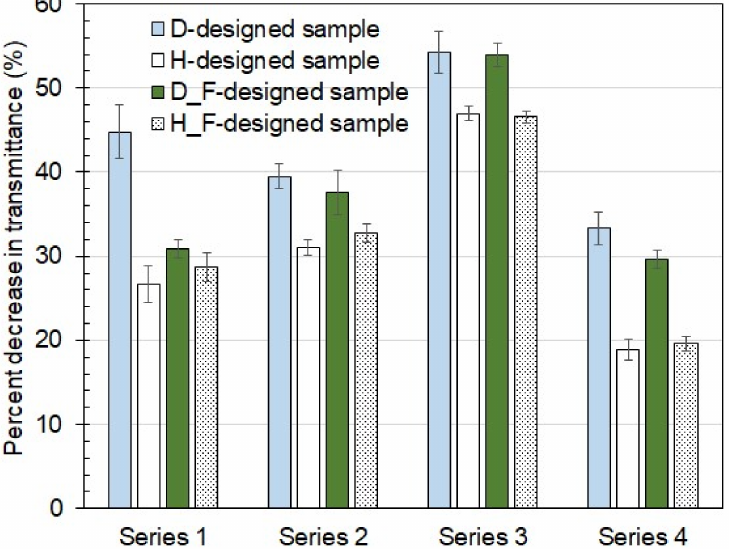
Figure 4. Water whitening of coating films expressed by a decrease in transmittance (1-day-long water